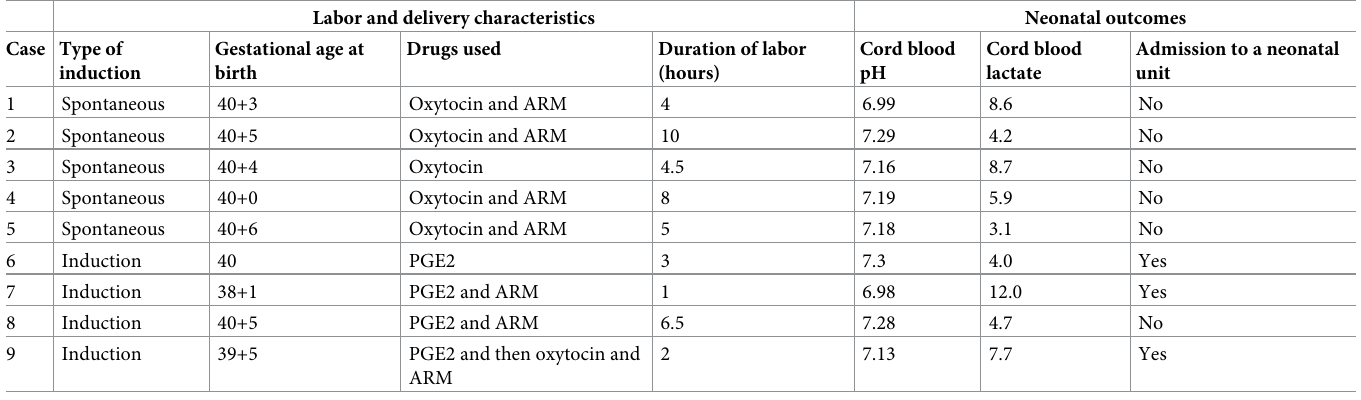
Table 5. Characteristics of the nine cases with uterine